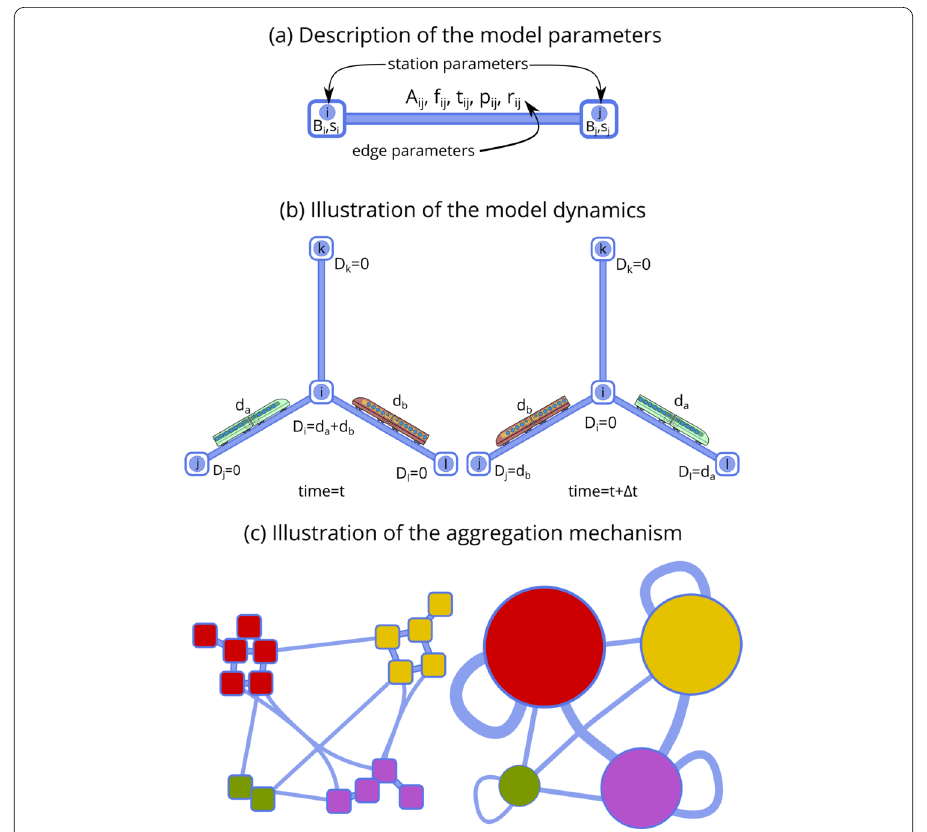
Figure 1 Model visualization: ( a ) station and line (edge in the network) dependent parameters, ( b ) illustration of the two mechanisms behind the delay dynamics dynamics, i.e. the appearance of new trains with